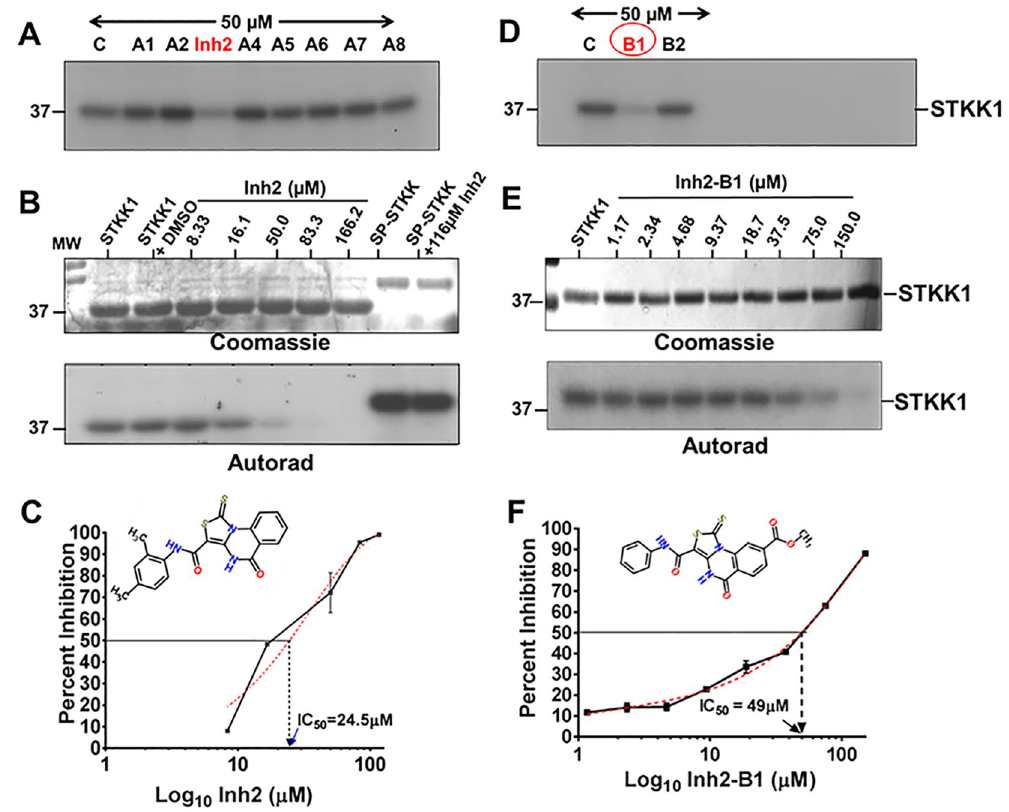
Figure 2. Identification of small molecule inhibitors targeted to S . aureus STK1. ( A , D ) Screening of Inh2- derivatives (50 µ M as indicated) for their ability to inhibit the kinase activity of S . aureus STKK1. ( B , E ) Coomassie-stained gels and corresponding autoradiograph show the dose-dependent inhibitory activity of a small molecule inhibitors, ( B ) Inh2 (N-(2,4-Dimethylphenyl)-5-oxo-1-thioxo-4,5-dihydro [1,3] thiazolo[3,4- α ] quinazoline-3-carboxamide) and ( E ) Inh2-B1 [Methyl 5-oxo-3-(phenyl carbamoyl)-1-thioxo-4,5dihydro[1,3] thiazolo[3,4-a]quinazoline-8-carboxylate] targeted to S . aureus STKK1 (the soluble kinase domain of STK1, 280 aa). ( C , F ) Quantitative analysis (IC 50 concentration) of Inh2 and Inh2-B1-mediated inhibition of STKK1 activity after 5 min pre-incubation. Each data point represents an average percent inhibition of three individual readings of radioactivity incorporation (radioactive counts per minute or CPM) (Mean ± SEM) in protein bands of samples treated with different concentrations of the inhibitor in comparison to control samples. CPM measured in the protein band of the control sample without inhibitor was treated as 100% incorporation or 0%